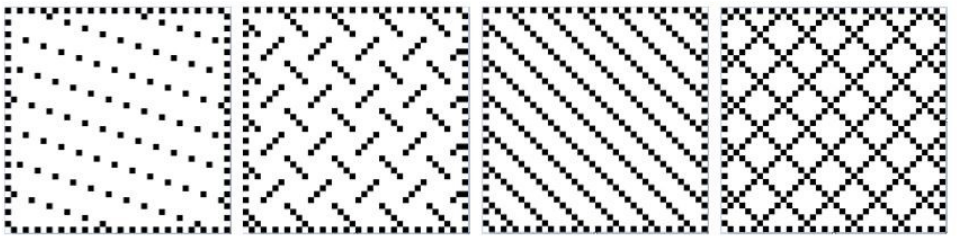
Figure 1. Pattern Types of woven electrodes. From Left to right: 1/15 Sateen, Broken Twill, Twill and Birdseye. Patterns are not to scale. Adapted from